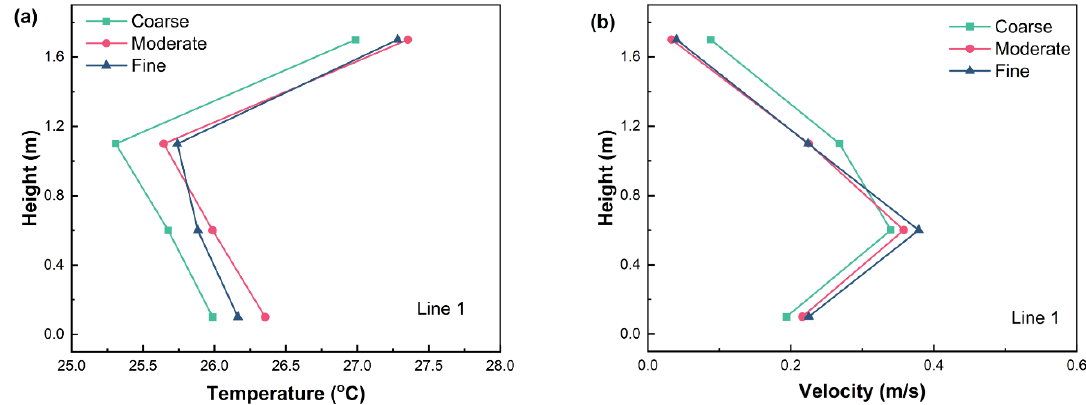
Figure 6. Comparison of different grid numbers: ( a ) air temperature; ( b ) air velocity.